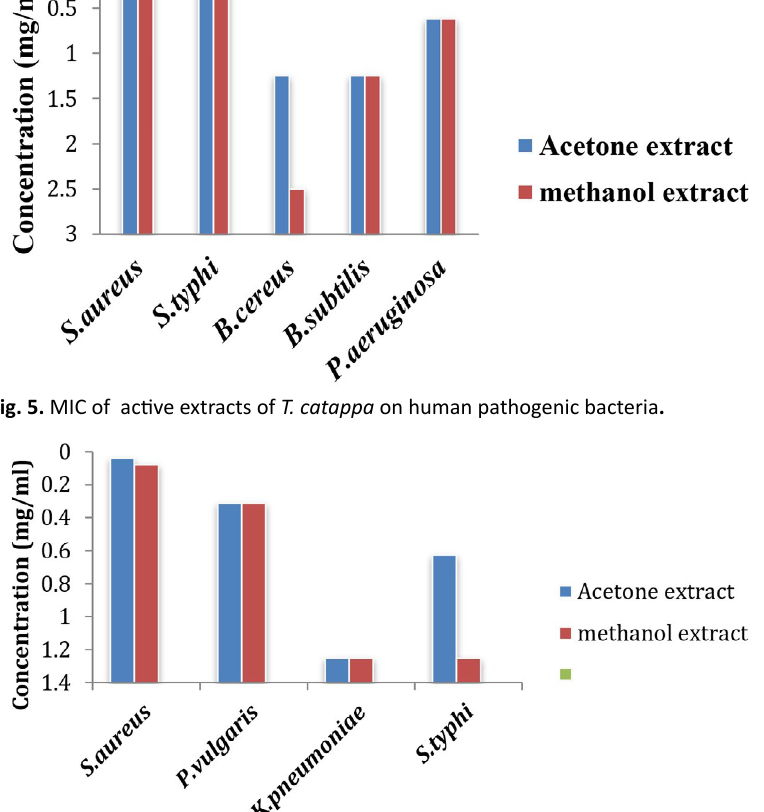
Fig. 6. MIC of active extracts of T. catappa on human pathogenic clinical